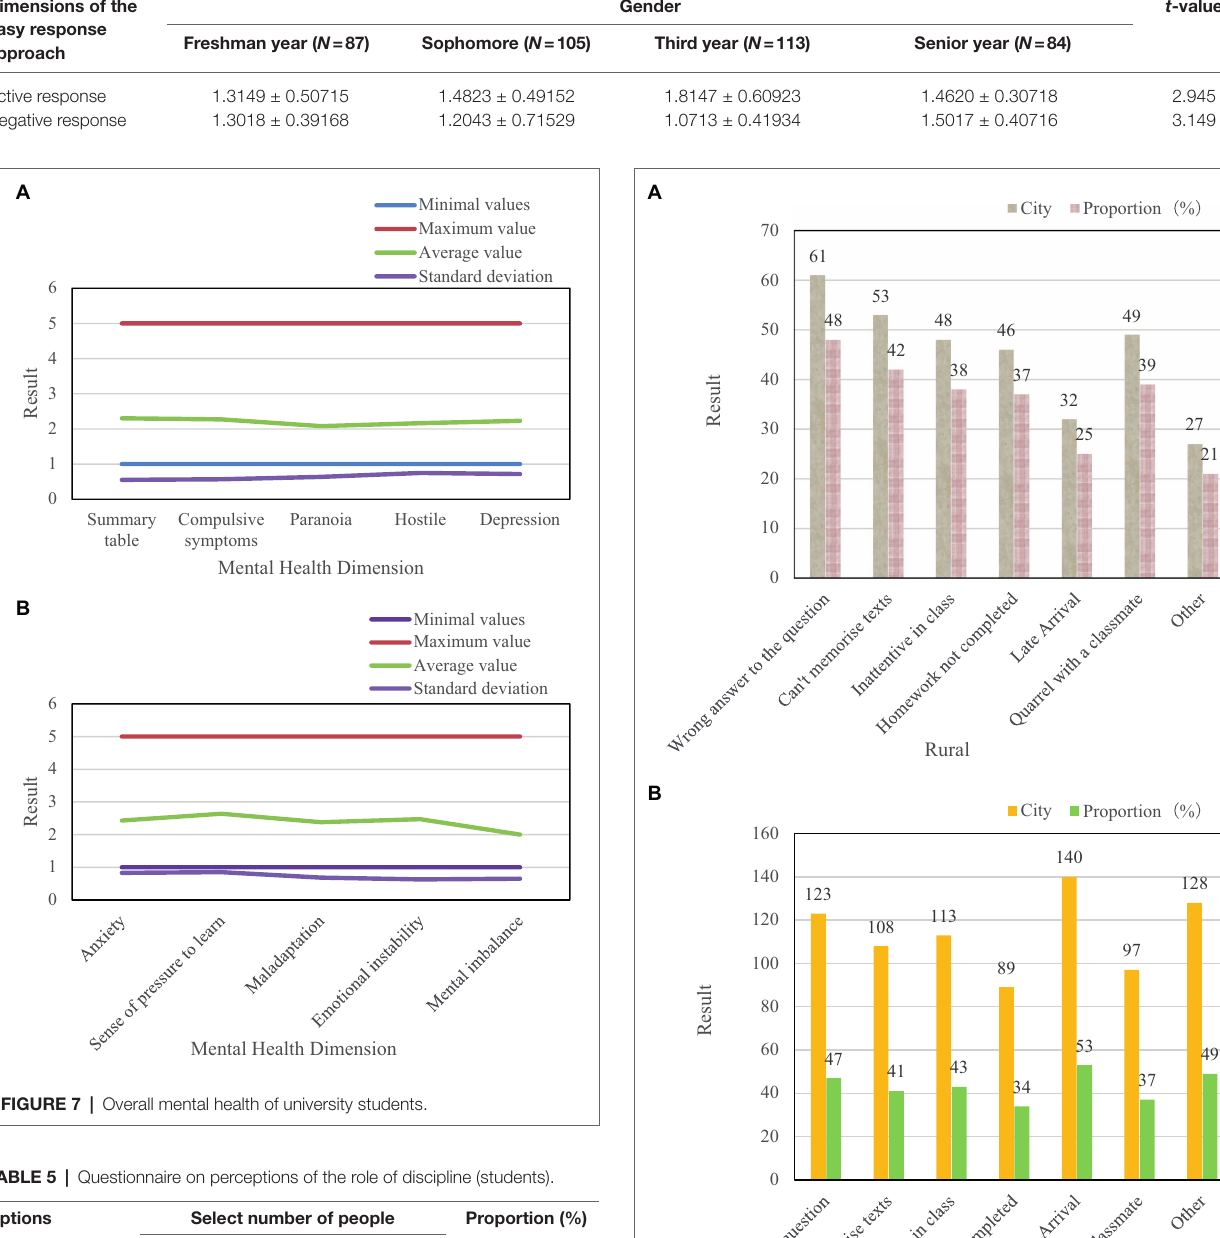
TABLE 4 | Analysis of differences in college students’ coping styles along the grade dimension.